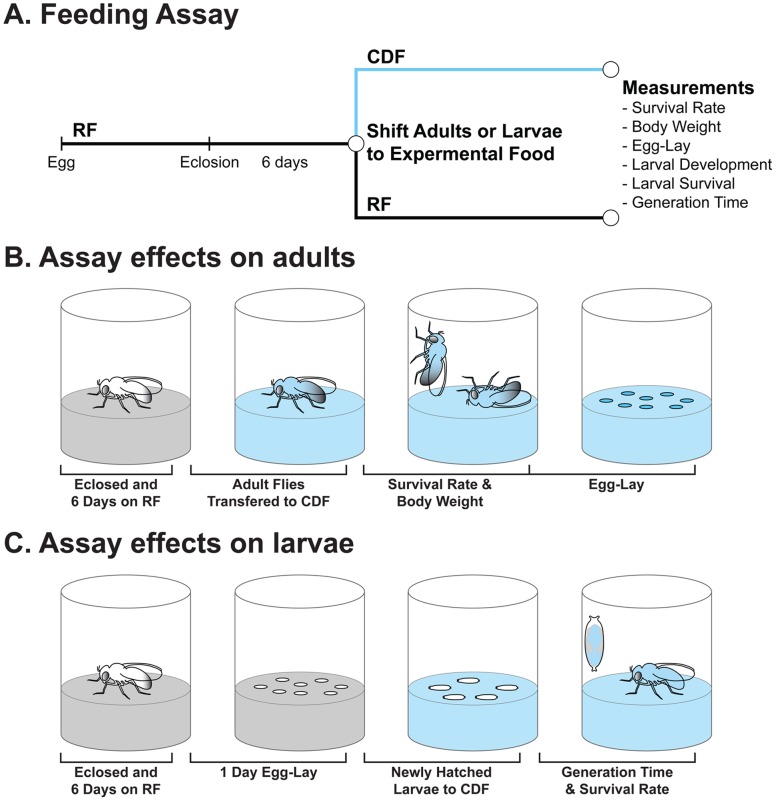
Experimental design.(A) General scheme for the feeding assays performed. Flies were grown and aged on regular food (RF) before shifting to chemically defined food (CDF). (B) Assays performed on adult flies. Body weight, survival, and egg-lay were measured after adult flies were shifted to chemically defined food. (C) Assays performed on developing flies. Larval development and survival were measured after newly hatched 1st instar larvae were shifted onto chemically defined food.